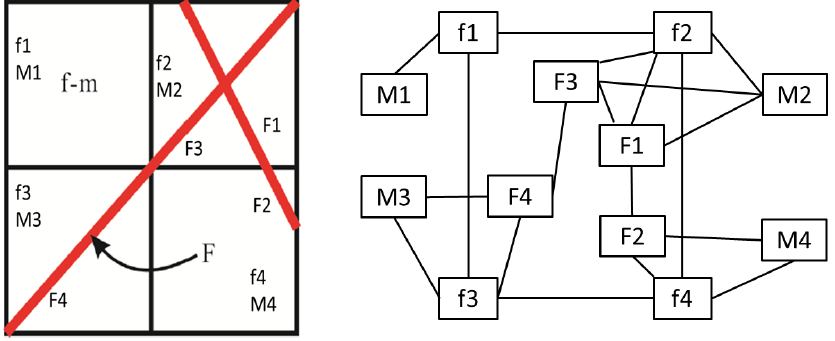
Figure 3. The example of connection list for EDFM+DP method.